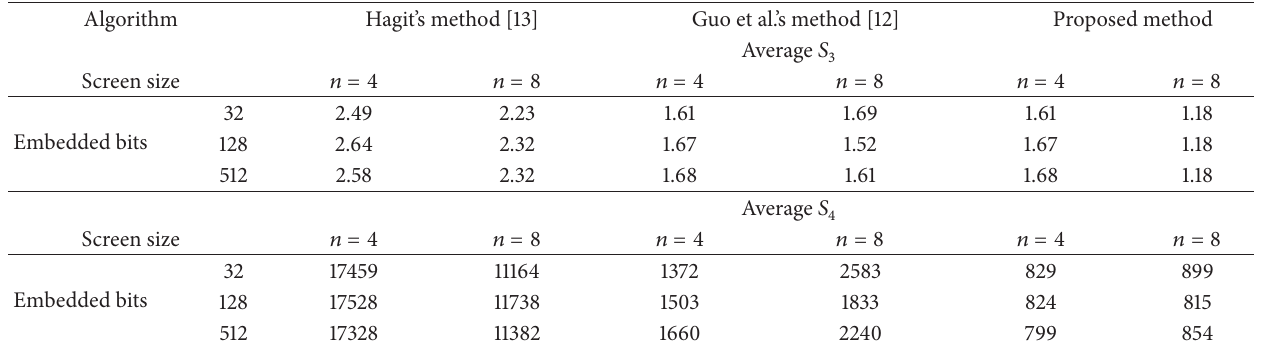
Table 4: Quality comparisons of various algorithms based on scores 𝑆 3 and 𝑆 4 [14].